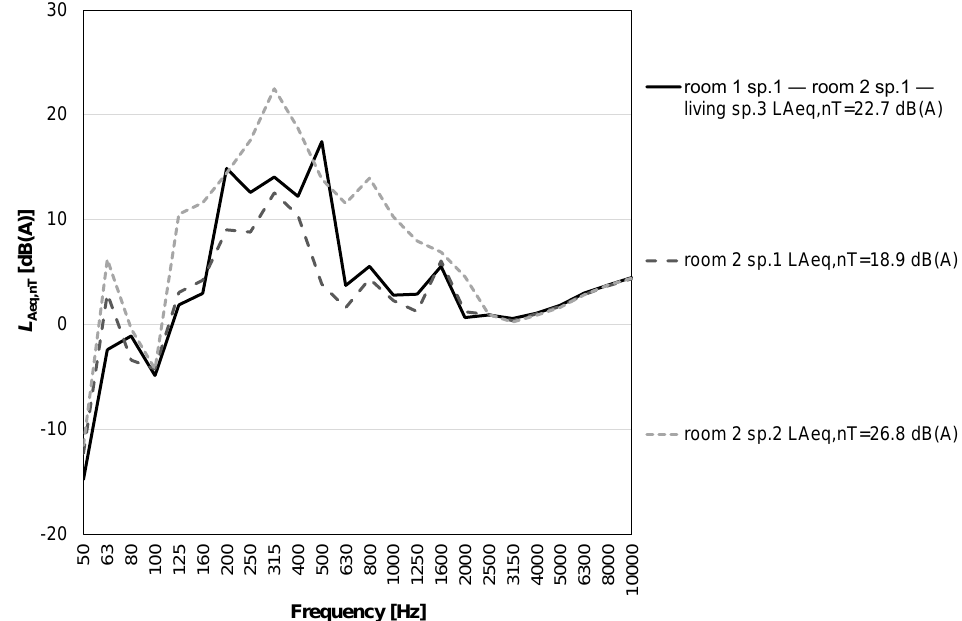
the CMV of bedroom 1, bedroom 2 and the living room. and speed 3 in the living room. This level was then compared with the ones obtained by setting speed 1 or speed 2 in bedroom 2 only. the background noise and the reverberation time according to the ISO 16032 standard are shown in Figure 7. Figure 6. Reverberation time of bedroom 1, bedroom 2 and living room.